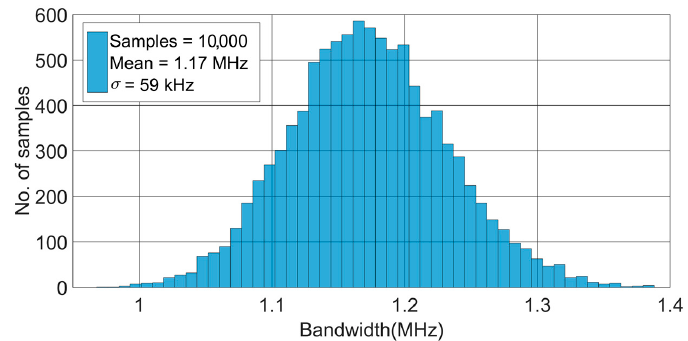
Figure 11. Monte Carlo simulation results for bandwidth for the maximum transimpedance configuration, 140 dB Ω .